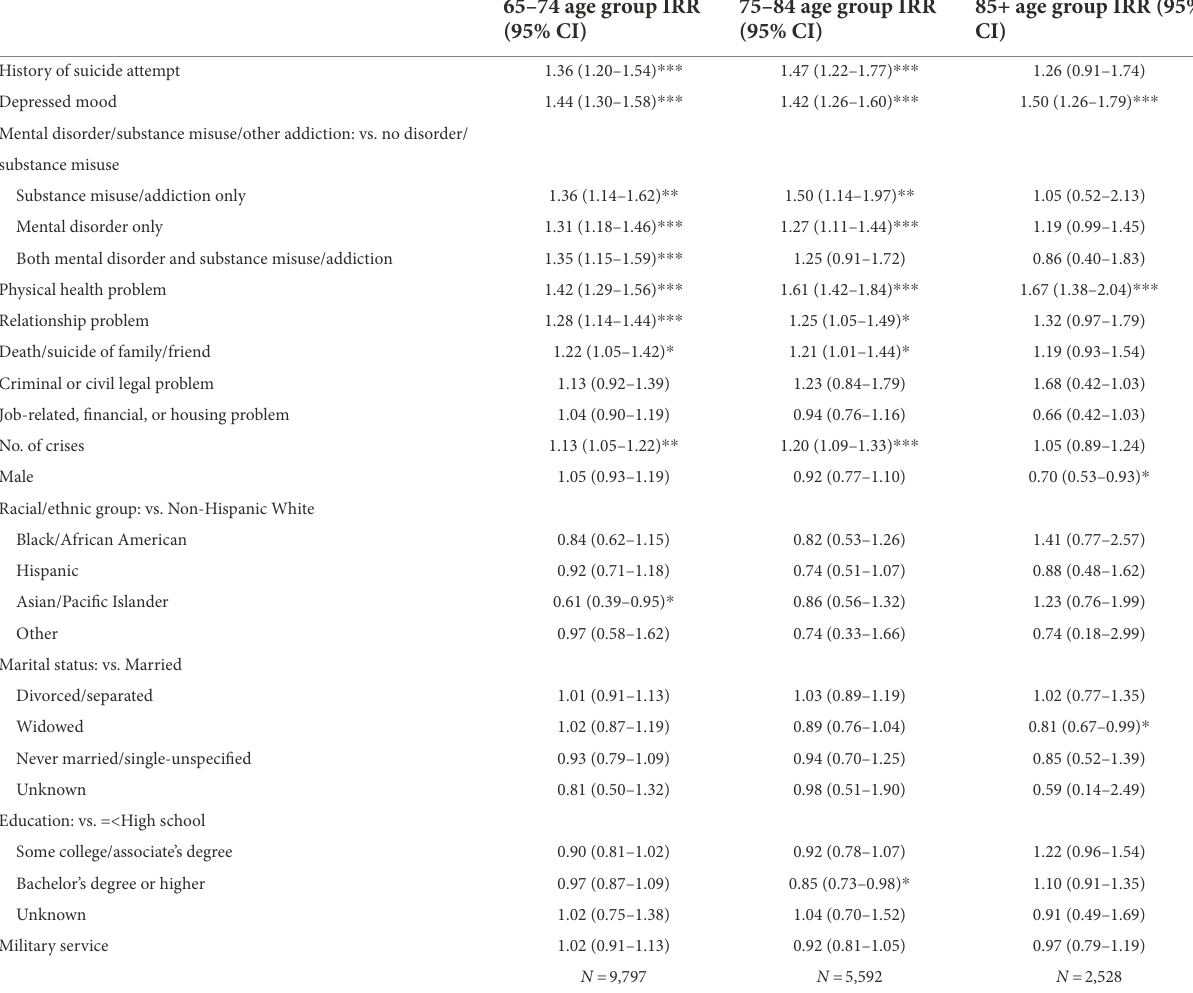
TABLE 4 Correlates of intent disclosure (vs. no disclosure) in each age group: Results from generalized linear models with Poisson and log